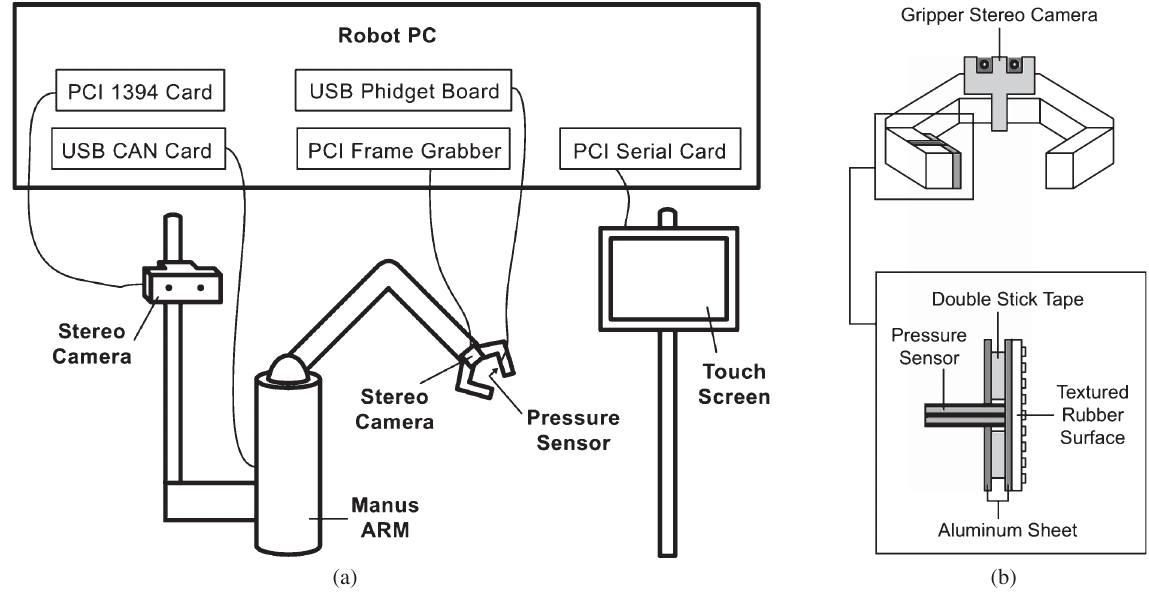
Fig. 1. (a) Our Manus ARM has been augmented with stereo cameras (over shoulder and in gripper) and a pressure sensor within the gripper. A touch screen or mouse-emulating joystick serve as the input device. (b) Diagram of the gripper and pressure sensor from overhead view.